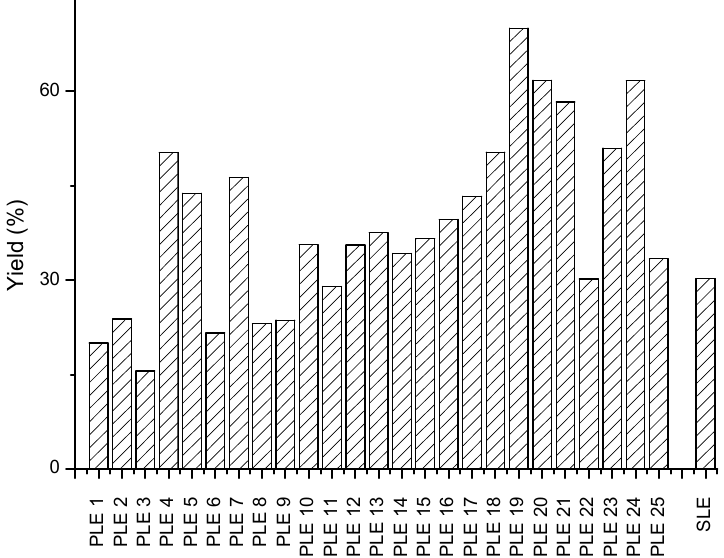
Figure 4. Extraction yield of different PLE experiments (1–25) and SLE extraction.